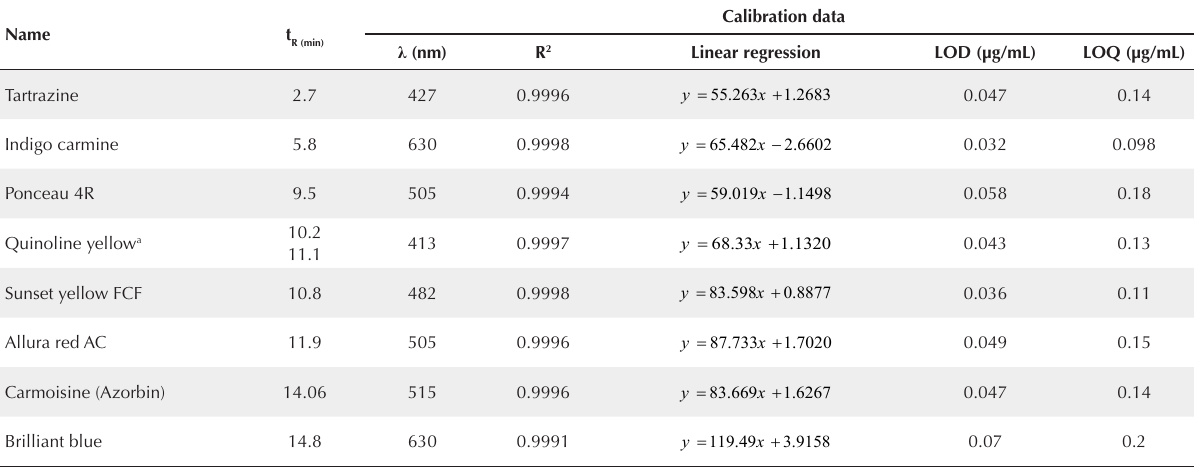
Table 3. Results of the analytical curves [ Retention time (t quantitation (LOQ)] for 8 synthetic colors using IP-HPLC-DAD